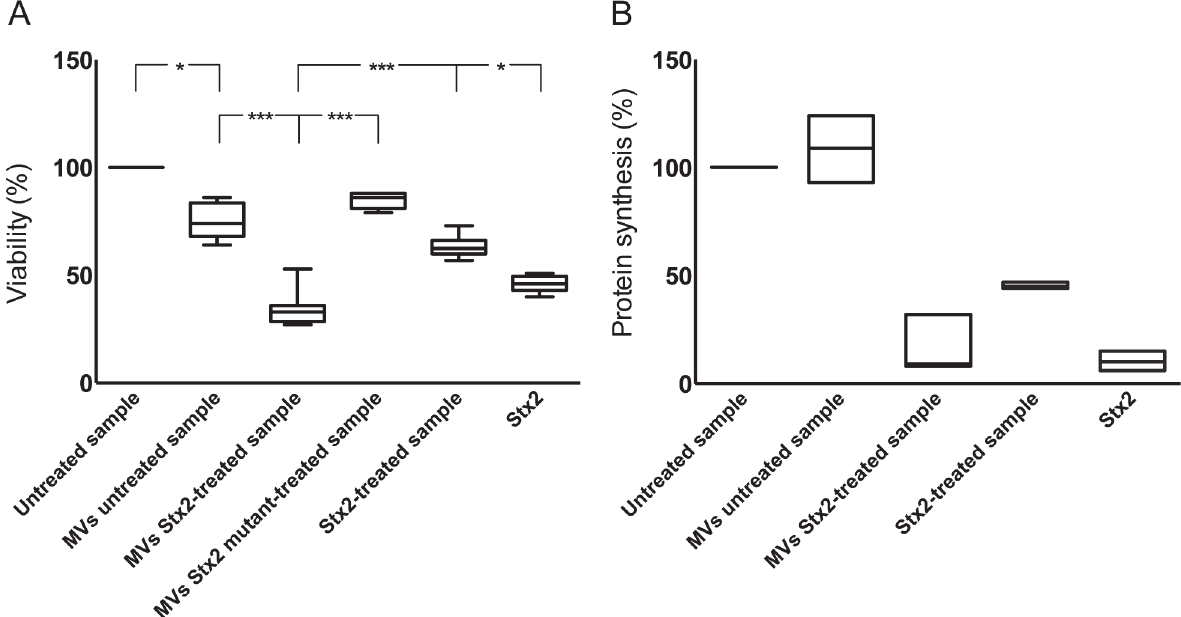
Fig 5. Microvesicles containing Stx2 affected the viability and inhibited protein synthesis in CiGEnC. The effect of Stx2-containing microvesicles on cell viability was examined by use of a crystal violet assay ( A ). Data are expressed as percentage of control cell viability defined as 100%. Representative data from five experiments are depicted as the median of triplicate wells. *** Denotes P value < 0.001 and * P < 0.05. ( B ) Protein synthesis was measured as the incorporation of [ 35 S]-methionine into total protein. Data are expressed as percent and 100% represents the untreated cells incubated under the same conditions but without microvesicles. All experiments were done in duplicate and the experiment was repeated three times. MVs untreated sample: whole blood was exposed to PBS for 1 hr, microvesicles (MVs) were isolated and incubated with CiGEnC for 36 hr; MVs Stx2-treated sample: isolated from whole blood treated with Stx2 (200 ng/mL diluted in PBS) for 36h; MVs Stx2 mutant-treated sample: isolated from whole blood treated with Stx2 mutated in the catalytic A subunit for 36h: Stx2-treated sample: purified Stx2 was exposed to washing steps similar to microvesicles before exposure to the cells; Stx2: cells were exposed to pure Stx2 (200 ng/mL) without washing